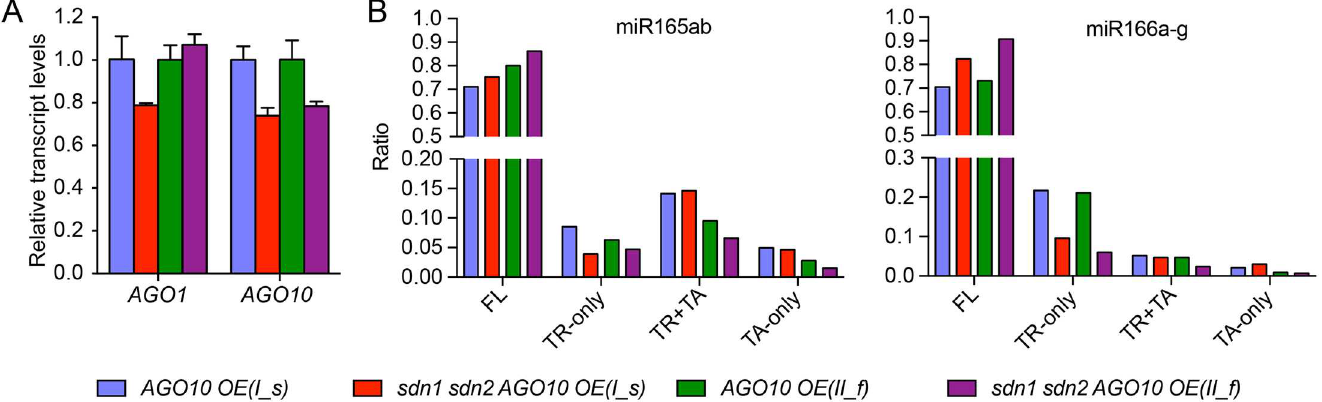
Fig 8. AGO10 overexpression-induced miR165/63 0 truncation requires SDN1 and SDN2 . (A) Relativetranscript levels of AGO1 and AGO10 in Col, AGO10 OE , and sdn1 sdn2 AGO10 OE plants. 35S :: YFP-AGO10 was introducedinto wild type and sdn1 sdn2 by transformation. Multiple T1 transgenic lines were screenedfor AGO10 expressionby real-time RT-PCR, and two independentpairs of lines (I and II) with similar AGO1 and AGO10 transcript levels were chosen for further analysis.For pair I, seedlingtissues were used for the analyses(denotedby “I_s”). For pair II, inflorescence tissues were used (denotedby “II_f”). (B) The composition of the four types (FL, TR-only, TA-only, TR+TA) of reads of miR165and miR166in AGO10 OE versus sdn1 sdn2 AGO10 OE . Note that the proportionof 3 0 TR-only reads was reducedand that of the FL reads was concordantly increasedin sdn1 sdn2 background. Althoughthe data shown here are from one biological replicate, the two pairs of samplesrepresentedtwo independentexperiments and showeda similar trend. Underlying data can be found in the GEO databaseas series GSE58138. The raw data for panels(A and B) can be found in S1